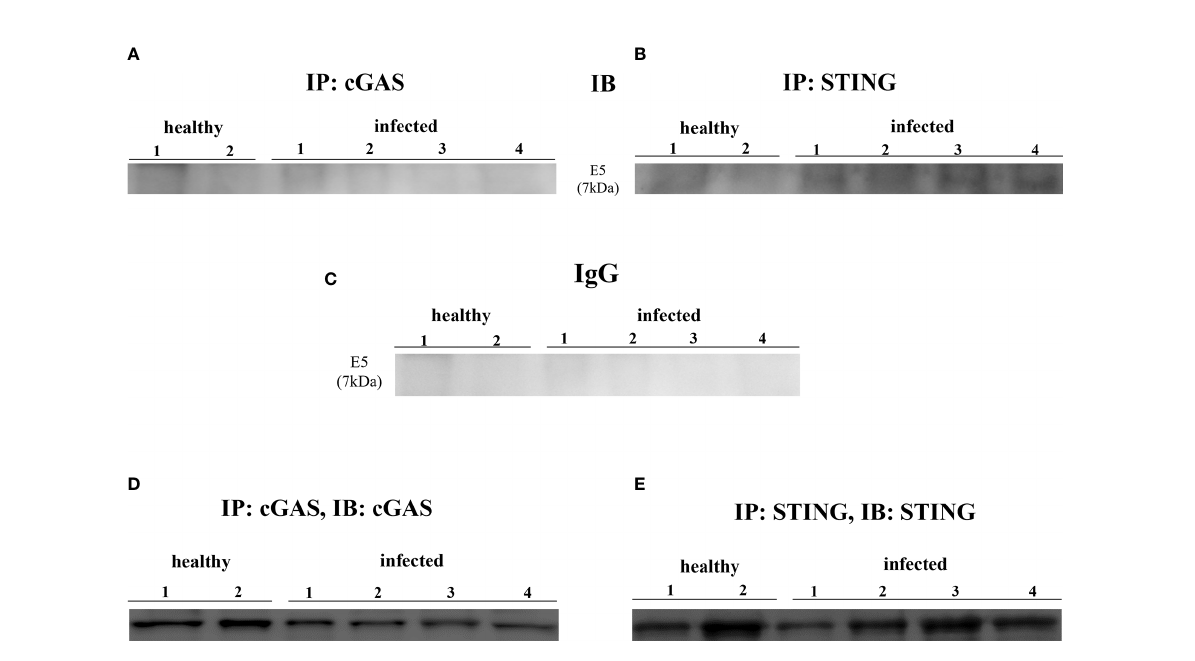
FIGURE 2 (A, B) cGAS and STING immunoprecipitation assay. Only STING bound E5 oncoprotein. (C) Rabbit IgG immunoprecipitation control. (D, E) Immunoprecipitation